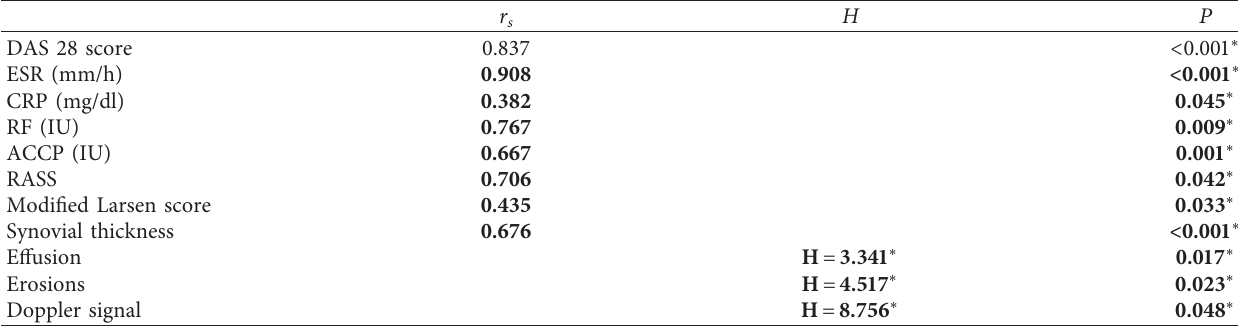
Table 3: Correlation between serum 14-3-3 η levels and demographic, clinical, laboratory, radiological, and ultrasonographic data in established RA